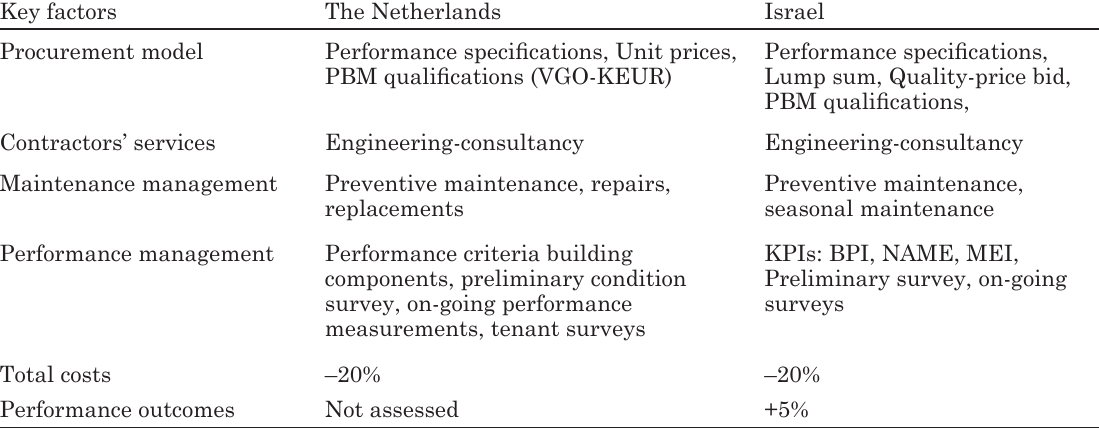
Table 3. Comparison between key factors of PBM contracting between the Netherlands and Israel Key factors